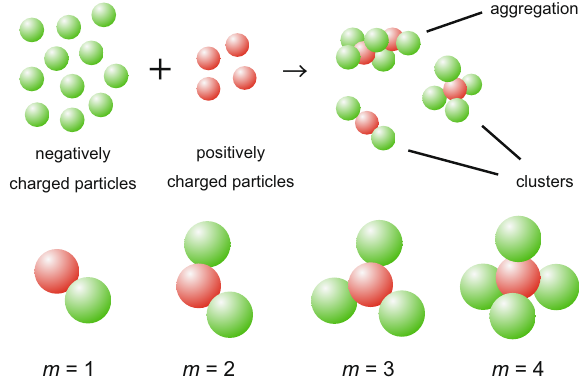
Fig. 1 Colloidal clusters. The schematic of clustering and clusters of positively and negatively charged colloidal particles. m is the association number.